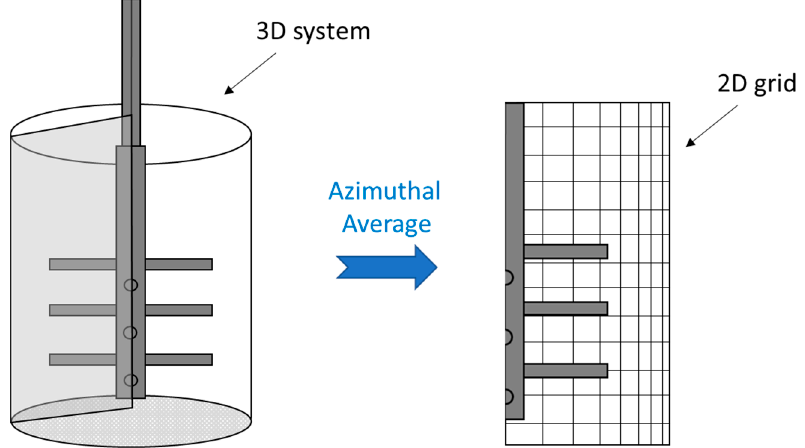
Figure 3. Schematic of the 2D grid utilised for the azimuthal average of the PEPT data.